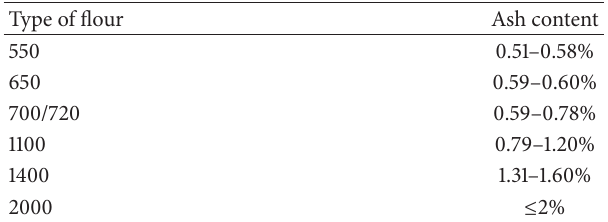
Table 1: Details of studied flour